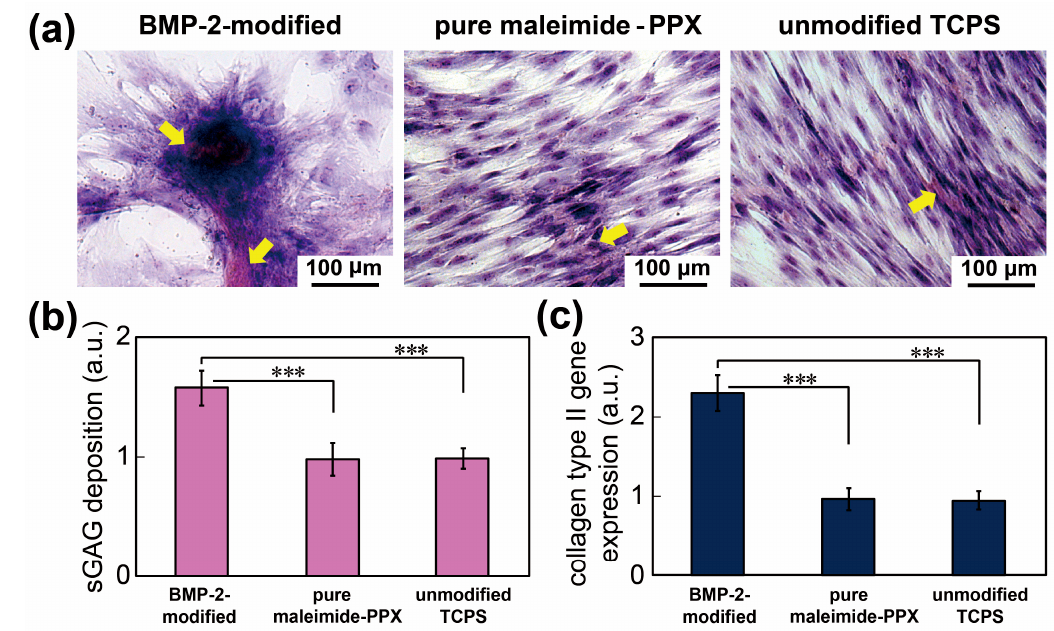
Figure 4. Chondrogenic activities of hADSCs were examined on the studied surfaces. ( a ) Toluidine blue staining was performed on day 14 to trigger the metachromatic color change (yellow arrows). The detected intensities from ( b ) sulfated glycosaminoglycan (sGAG) by using a spectrophotometric 1,9-dimethylmethylene blue (DMMB) dye binding assay and ( c ) the chondrogenic marker collagen type II gene expression by quantitative PCR analysis were statistically analyzed and compared for the studied surfaces. The data bars represent the mean value (n = 3) and the standard deviation (±SD) based on three independent experiments. The significance level *** stands for *** p < 0.001, and is shown by the results of the unpaired t -test.